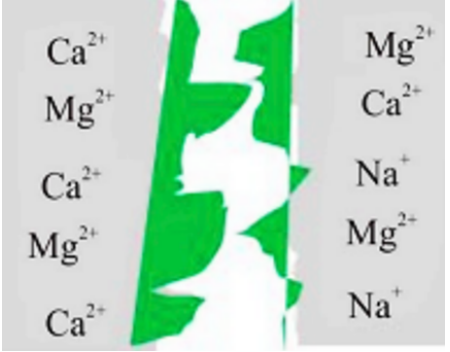
Figure 6. Adsorption of polymer molecules due to divalent ions causing permeability reduction under HTHS conditions (Reproduced from Firozjaii and Saghafi, 2020